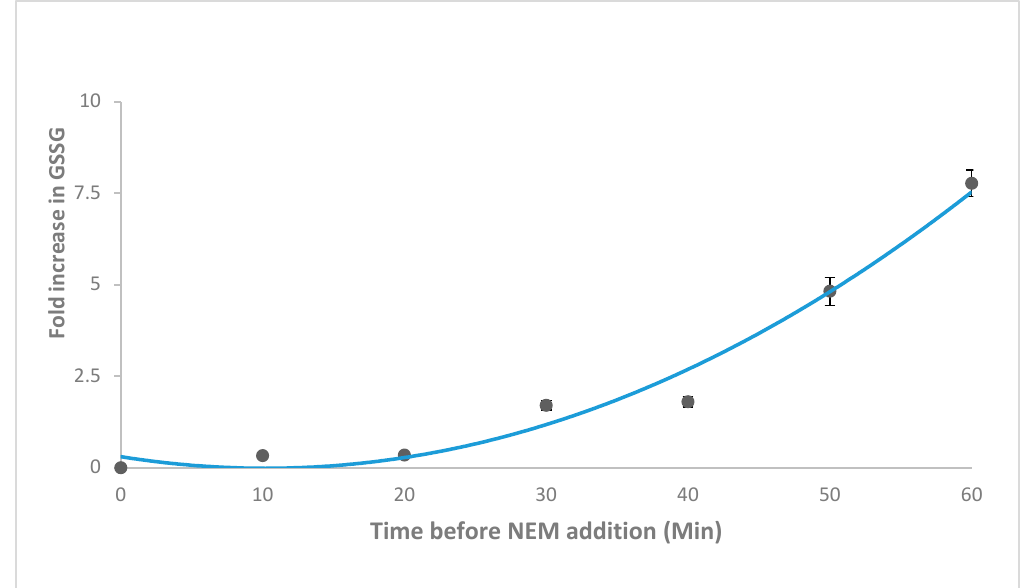
Figure 5. Time dependent auto-oxidation of reduced glutathione (GSH) with fold increase in oxidised glutathione (GSSG). 200 uM GSH was subjected to GSSG assay protocol at di ff erent incubation times. Samples were incubated at 4 ◦ C for varying times, 40 mM NEM was added and incubated with O-pthaldialdehyde (OPA) for 25 min. Data are presented as mean ± SEM ( n =